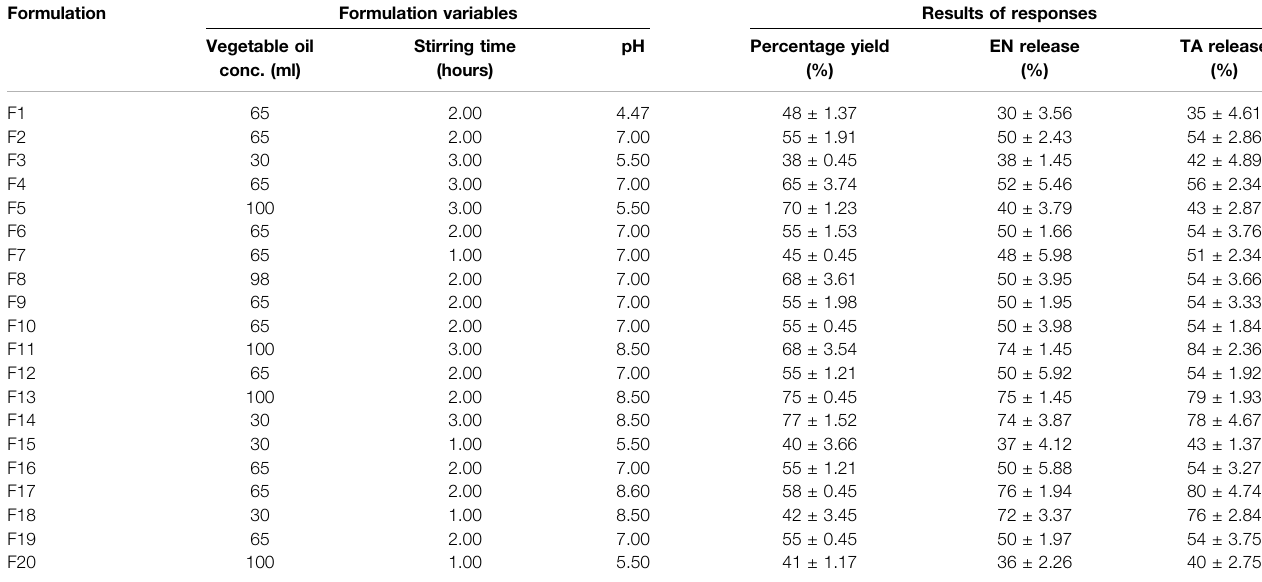
TABLE 1 | Composition of various formulations designed by CCRD and results of percentage yield and drugs release. Formulation Formulation